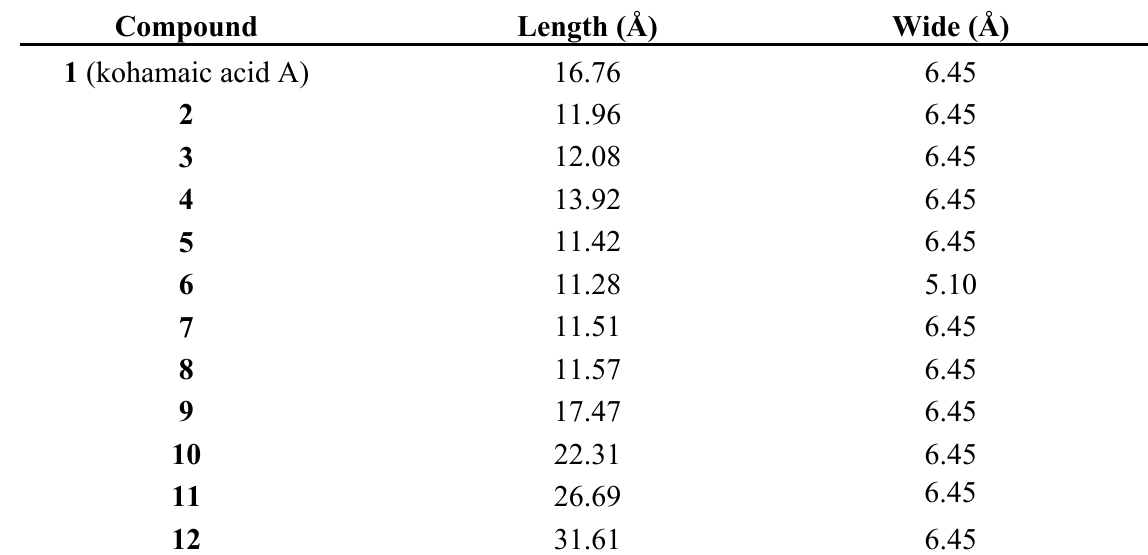
Table 5. The molecular length and wide of three-dimensional structure of kohamaic acid A derivatives (compounds 1 – 12